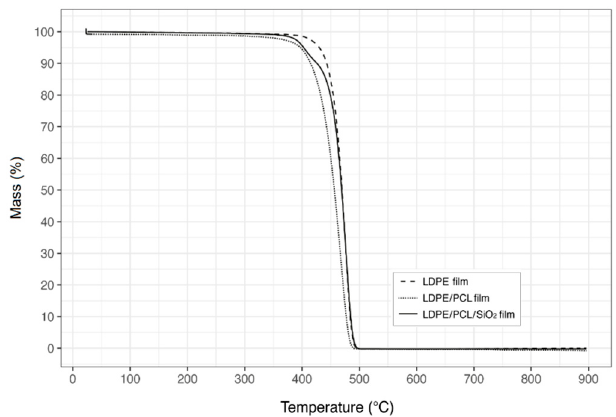
Figure 7. Thermogravimetric analysis (TGA) curves of low-density polyethylene (LDPE) (dashed line), LDPE/poly( ε -caprolactone) (PCL) film (dotted line), and of LDPE/PCL/silica (SiO 2 ) (black line) films. PCL and SiO 2 layers were electrospun and electrosprayed for 120 and 60 min, respectively, and then annealed.